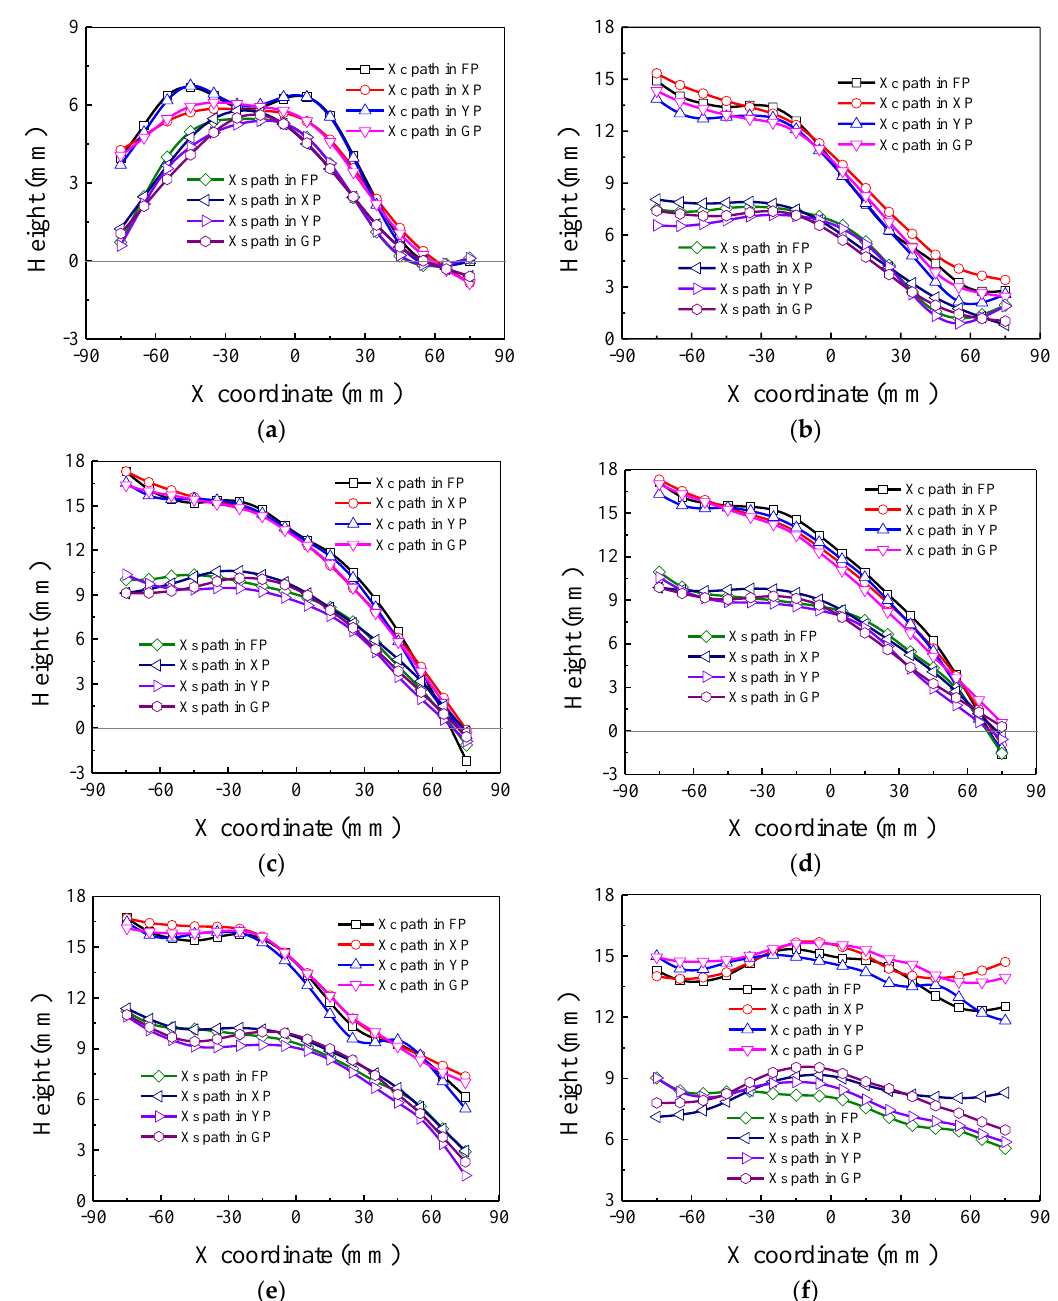
Figure 19. Z direction height distribution along X direction paths of four panels during EMIF: ( a ) t = 0.15 ms; ( b ) t = 0.75 ms; ( c ) t = 0.90 ms; ( d ) t = 1.60 ms; ( e ) t = 1.75 ms; and ( f ) t = 2.45 ms. Xc and Xs represent X center web-bottom path and X side web-bottom path, respectively.